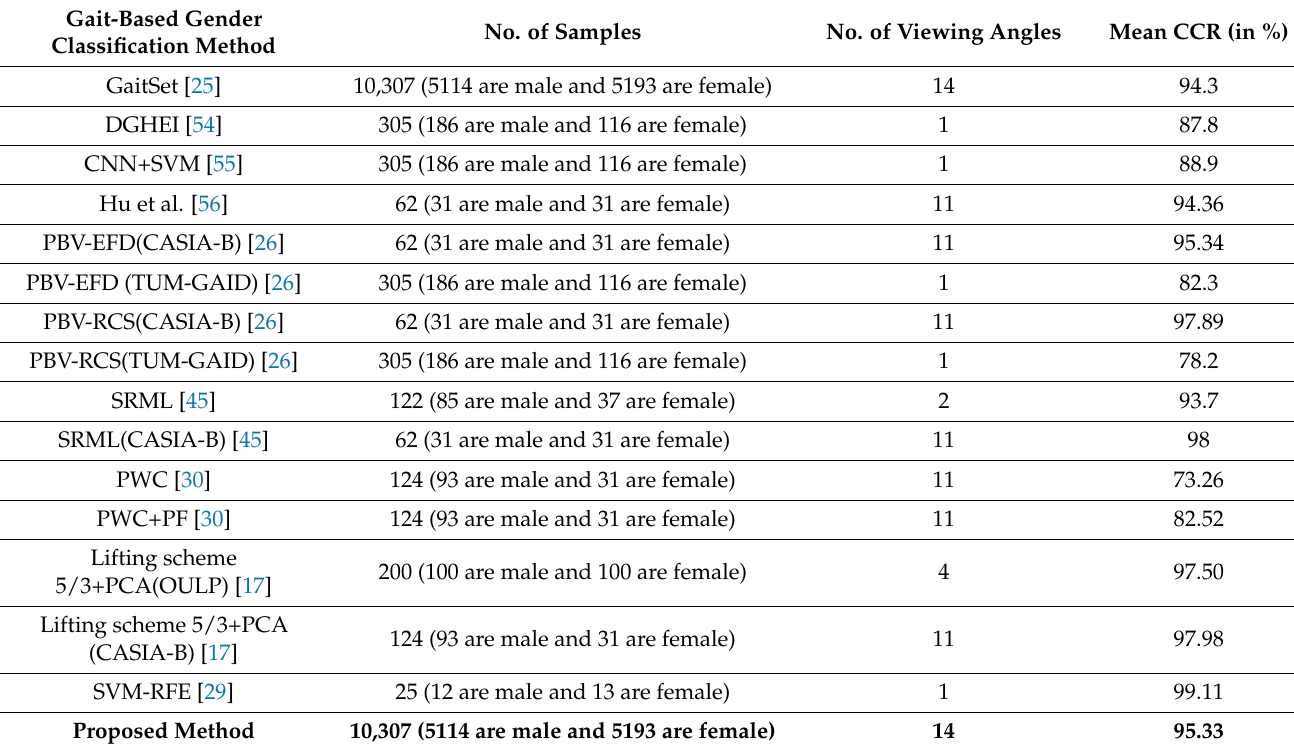
Table 3. Statistical analysis of gait-based gender classification methods.